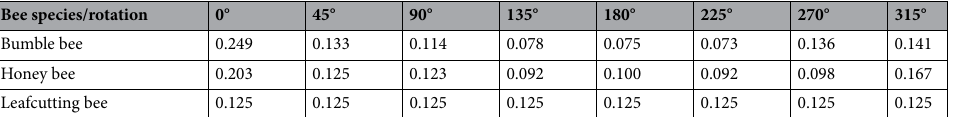
Table 5. The transition vector for each bee species. The rotation indicates a 0°, 45°, 90° or larger angle rotation to the left from one movement between racemes to the next. For 0° rotation, the bee kept moving in the same direction while for a 180° rotation it reversed direction. A probability of 0.125 was used for each angle rotation for leafcutting bee.